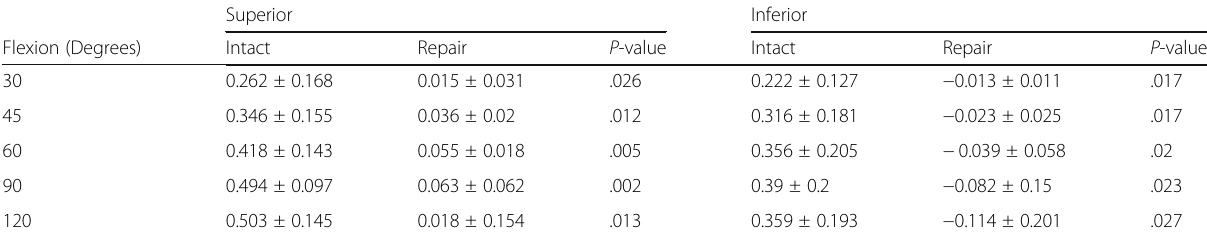
Table 1 Superior and inferior MPFL strain for intact and reconstructed double-bundle knee specimens ( n = 6)